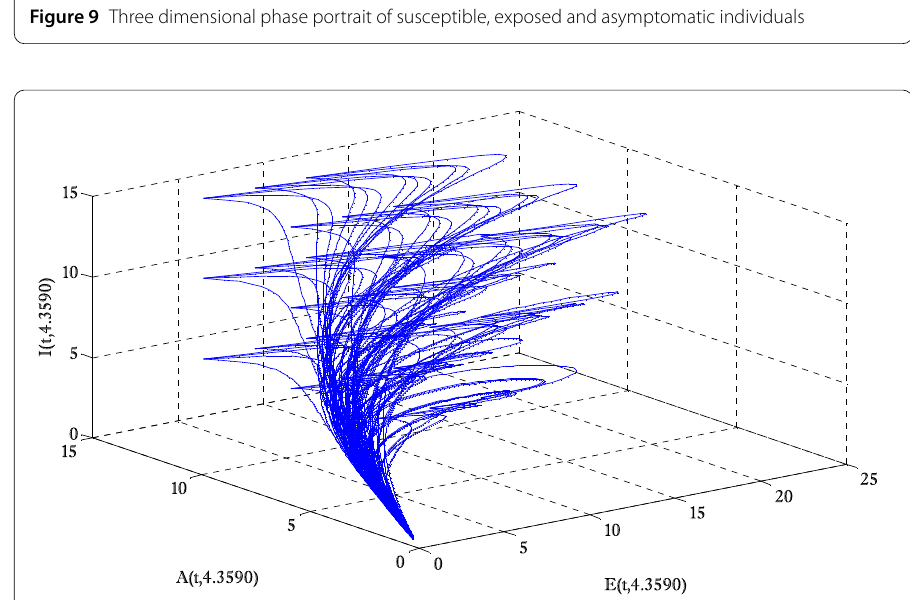
Figure 10 Three dimensional phase portrait of exposed, asymptomatic and infected individuals